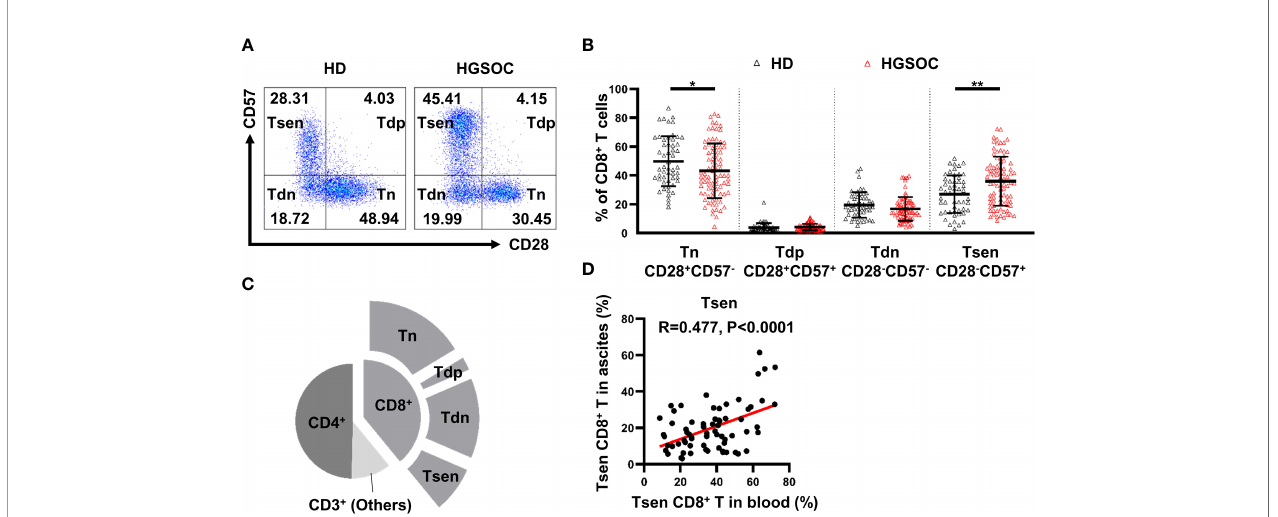
FIGURE 1 | CD28 − CD57 + CD8 + T cells are present in the peripheral blood and ascites from untreated patients with HGSOC. (A) Representative fl ow cytometry plots are presented for CD28 and CD57 expression by CD8 + T cells in the peripheral blood of healthy donors (HDs, n = 53) and patients with high-grade serous ovarian cancer (HGSOC, n = 86). Values in plots represent percentages. (B) Proportion of CD8 + T-cell subsets: CD28 + CD57 − (Tn), CD28 + CD57 + (Tdp), CD28 − CD57 − (Tdn), and CD28 − CD57 + (Tsen). Groups were compared using t-test (Tsen) or Mann – Whitney U-test (Tn, Tdp, and Tdn). Bars show mean with SD. (C) Proportion of CD4 + and CD8 + subsets within CD3 + population in ascites (n = 68). (D) The correlation between the frequency of Tsen CD8 + T cells in the peripheral blood and ascites from the same patient with HGSOC (n = 68) was analyzed by Spearman ’ s rank coef fi cient. HD, healthy donors; HGSOC, high-grade serous ovarian cancer. *, P < 0.05; **, P <